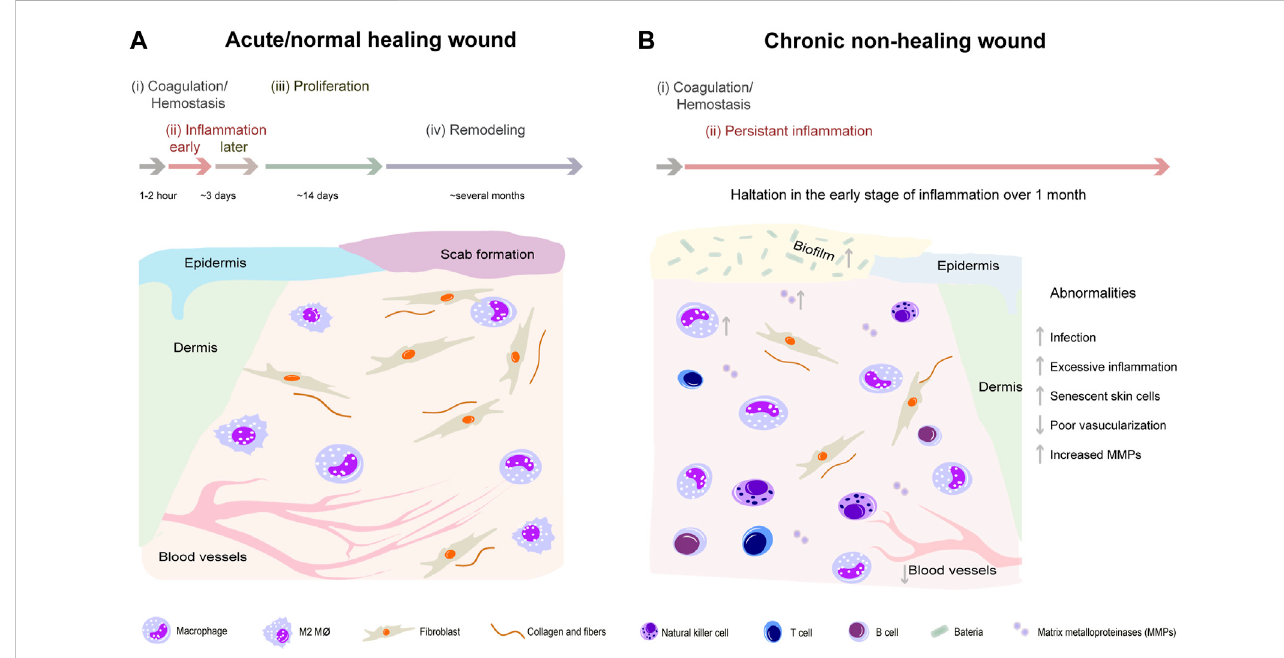
FIGURE 1 Comparison ofrepresentativepathophysiological processes between normalhealingwoundsand chronicnon-healing wounds.Normalwoundhealing process can be divided into four distinct and overlapping phases: hemostasis, in fl ammation, proliferation, and remodeling (A) . However, chronic wounds usually haltat in fl ammation phase and aredif fi cultto healbecauseofexcessive in fl ammation, senescent skin cells, poorvascularization,and increased matrix metalloproteinases (B) .